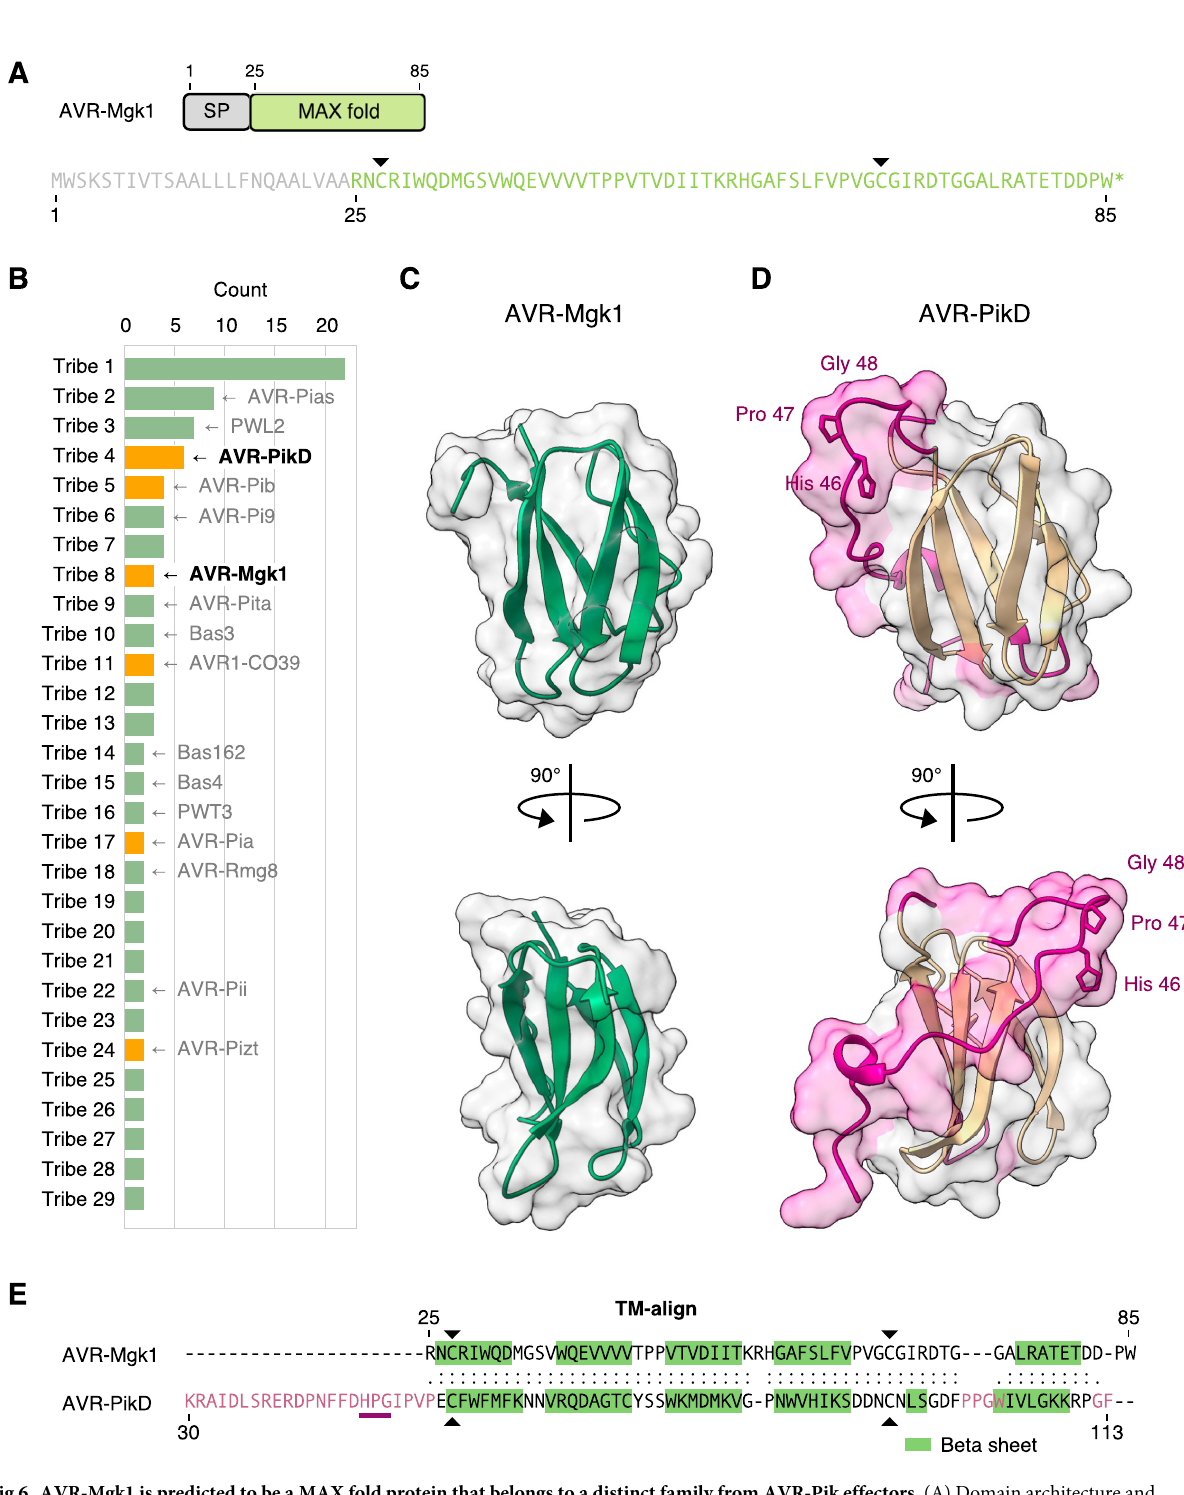
Fig 6. AVR-Mgk1 is predicted to be a MAX fold protein that belongs to a distinct family from AVR-Pik effectors. (A) Domain architecture and amino acid sequence of AVR-Mgk1. We used SignalP v6.0 [106] to predict SP sequences in AVR-Mgk1. AVR-Mgk1 has the 2 cysteine residues (Cys27 and Cys67, indicated by black arrowheads) conserved in the MAX effector superfamily. (B) Clustering of putative M . oryzae AVR protein sequences using TRIBE-MCL [107]. Tribe-MCL assigned AVR-Mgk1 and AVR-PikD into different tribes. If a tribe includes an experimentally characterized protein, it is shown to represent the tribe. If a tribe includes an experimentally validated MAX effector protein or AVR-Mgk1, the tribe is shown in orange. Tribes having only 1 protein are not shown. (C) AVR-Mgk1 protein structure predicted by AlphaFold2 [108]. AVR-Mgk1 has antiparallel β sheets, characteristic